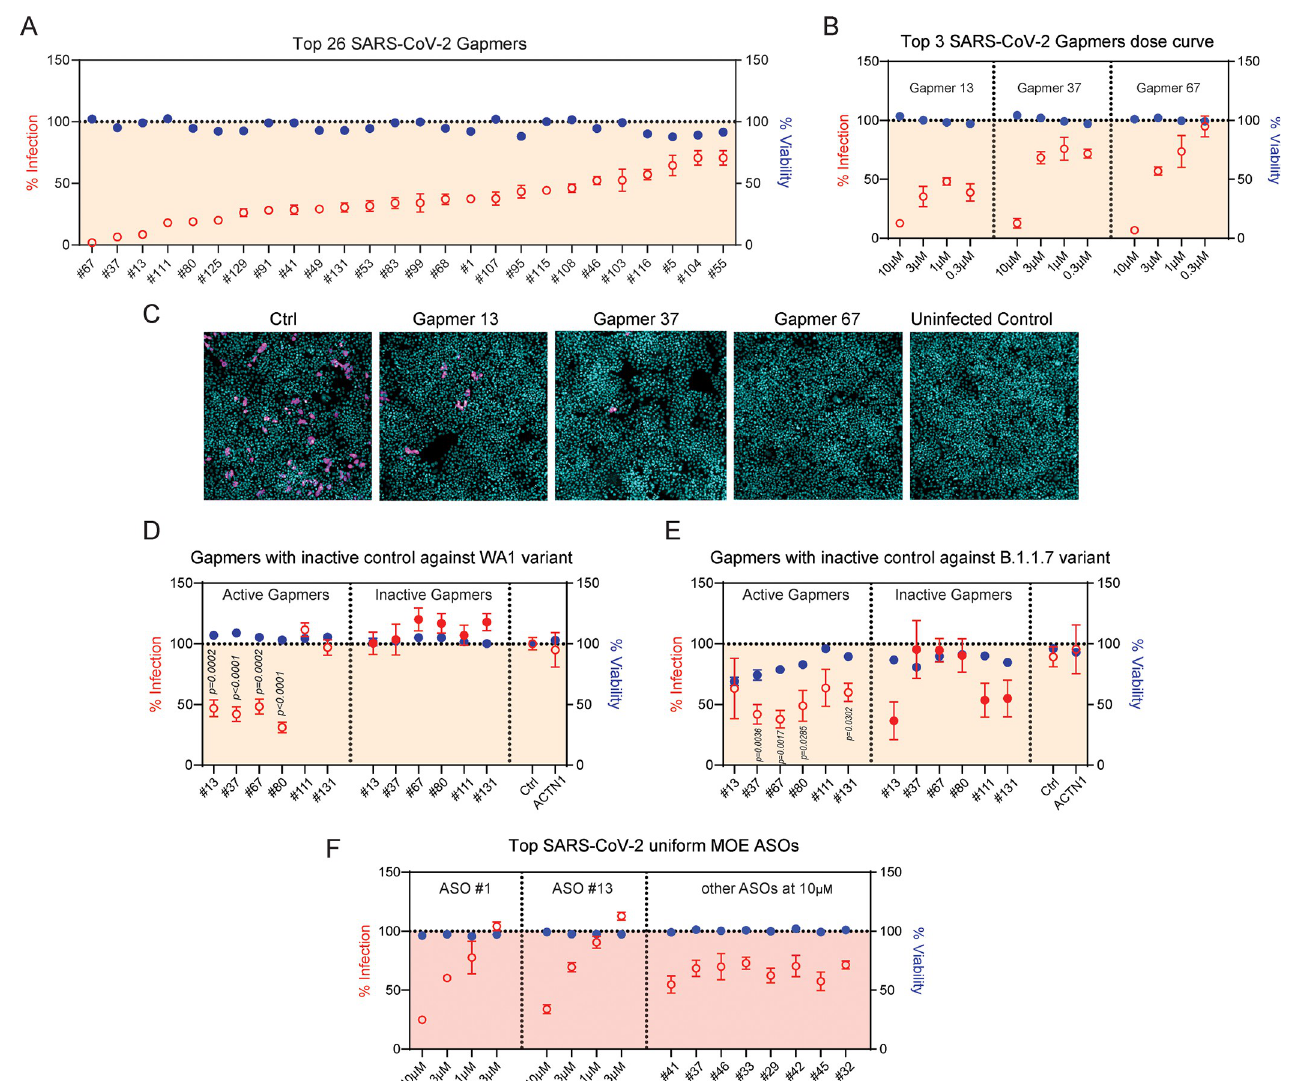
Fig 2. Antiviral screen of SARS-CoV-2 ASOs in H1437 cells. (A) SARS-CoV-2 bioassay showing infectivity and cell viability with the most active 26 SARS-CoV-2 Gapmers at 10 μ M against WA1 strain in H1437 cells. (B) SARS-CoV-2 bioassay showing infectivity and cell viability with the most active 3 SARS-CoV-2 Gapmers at 10, 3, 1, and 0.3 μ M treatments against WA1 strain in H1437 cells. (C) Representative images of H1437 cells after 10 μ M indicated ASOs treatment. (D) SARS-CoV-2 bioassay showing infectivity and cell viability with the most active SARS-CoV-2 Gapmers and corresponding inactive controls at 3 μ M against WA1 strain in H1437 cells. P values were calculated using two tailed unpaired t test by comparing to control (Ctrl). (E) SARS-CoV-2 bioassay showing infectivity and cell viability with the most active SARS-CoV-2 Gapmers and corresponding inactive controls at 3 μ M against B.1.1.7 strain in H1437 cells. P values were calculated using two tailed unpaired t test by comparing to control (Ctrl). (F) SARS-CoV-2 bioassay showing infectivity and cell viability with the most active SARS-CoV-2 uniform MOE ASOs and corresponding inactive controls at 3 μ M against WA1 strain in H1437 cells.